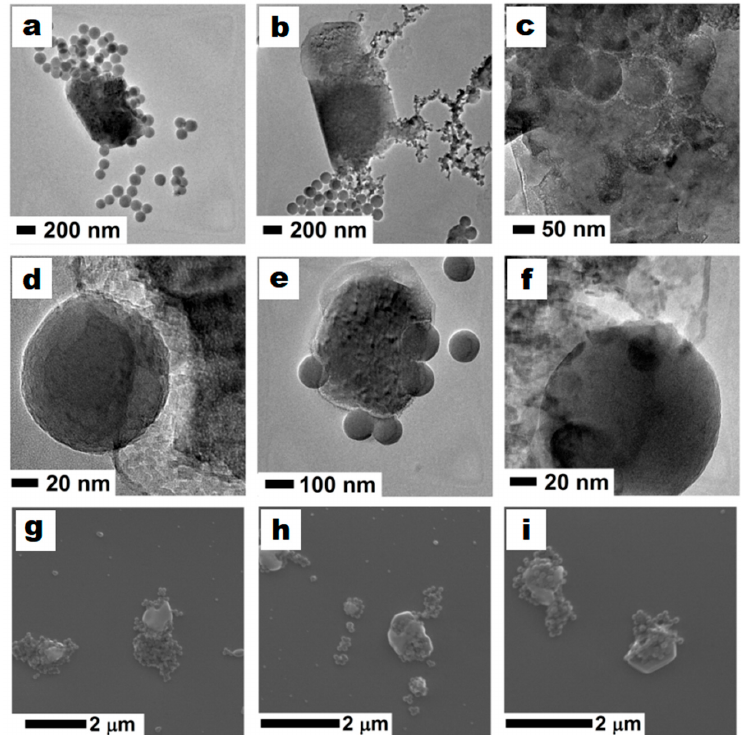
Figure 6. TEM (upper and middle panel) and SEM (lower panel) images of the Oenococcus oeni (DSM7008) cells stirred with the silica nanospheres (after 60 min). O. oeni (DSM7008) cell after silica nanosphere impact ( a ), cell deformation and release of its cytoplasmic matter ( b ), silica nanospheres inside bacteria cell ( c ), silica spheres immersed in a cell’s surface ( d–f ), SEM confirmation of large bacteria deformations and silica nanospheres surrounding O. oeni cells ( g–i ).